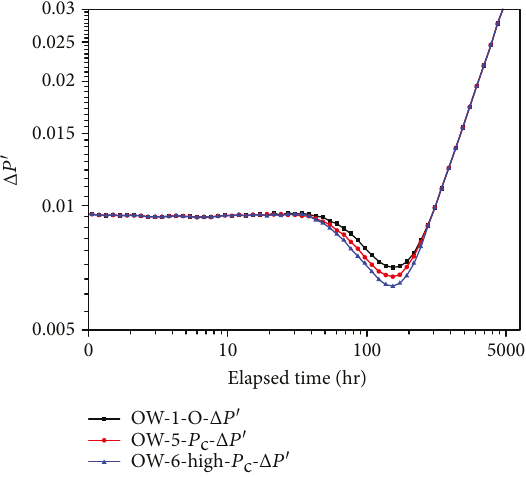
Figure 12: The log-log plot of drawdown of a closed system. It shows that the transition zone pressure derivative of reservoir with capillary pressure goes down more than that without capillary